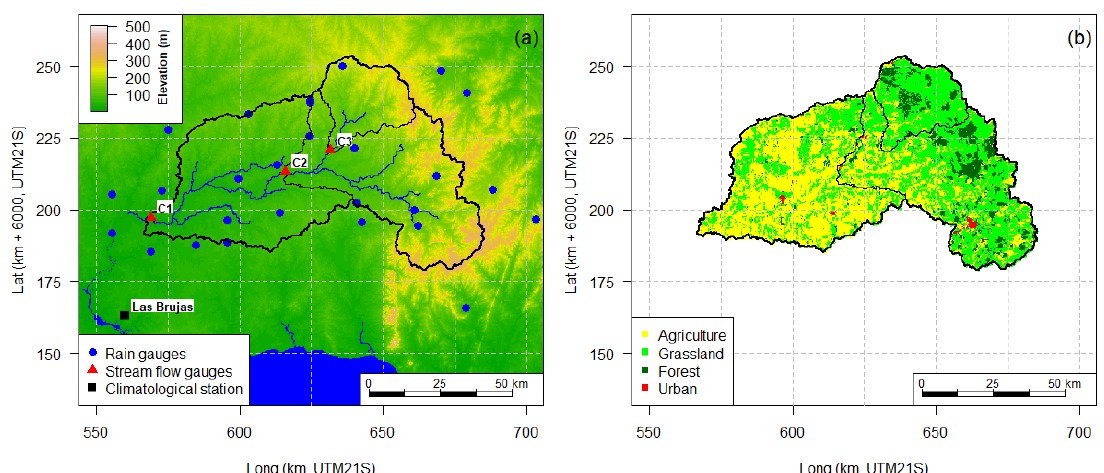
Figure 1. ( a ) Relief, monitoring system and sub-catchments of Santa Lucía at Paso Pache (C1, 4896 km 2 ), Fray Marcos (C2, 2744 km 2 ) and Paso de los Troncos (C3, 687 km 2 ). ( b ) Main land uses observed during 2015.